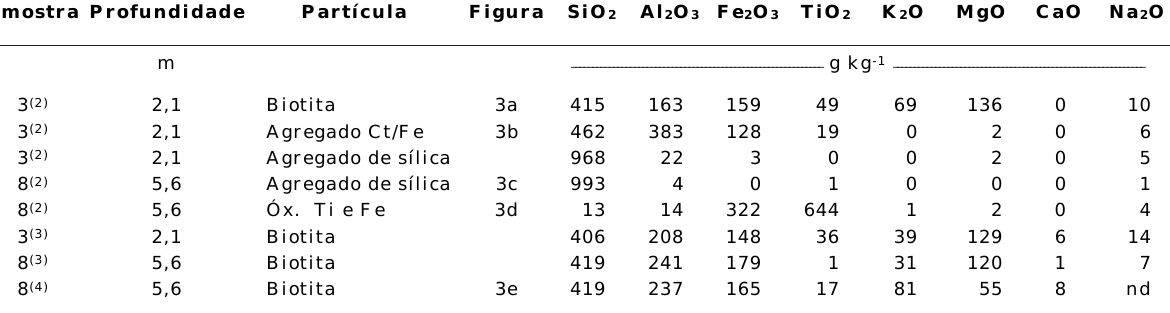
(1) Dados médios normalizados. Agregado Ct/Fe - agregado de caulinita e óxido de ferro, Óx. Ti e Fe - óxido de Ti e Fe. (2) Fração areia. (3) Fração silte. (4) fração argila. nd, não determinado. Na figura 3, são apresentadas fotomicrografias de algumas partículas